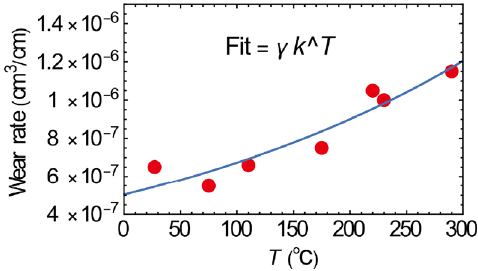
Fig. 16 Wear rate with temperature for 60/40 brass on tool steel. Reproduced with permission from Ref. [31], © Springer Nature 2020.